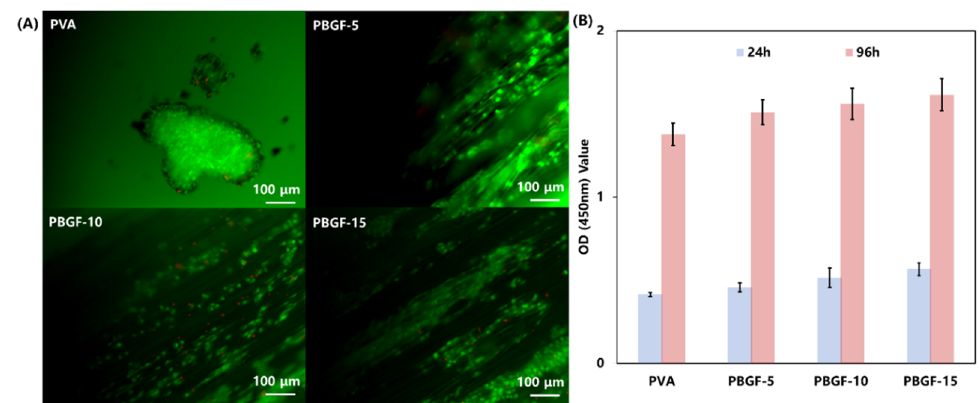
Figure 7. ( A ) Live/dead staining of chondrocytes seeded on hydrogel after being cultured for 96 h. The live cells are stained green by FDA, while the dead cells are stained red by PI. The scale bar is 100 nm. ( B ) CCK-8 test for the proliferation of chondrocytes on the hydrogel and composites by 24 h and 96 h. Data are expressed as means ± SD (n = 5).